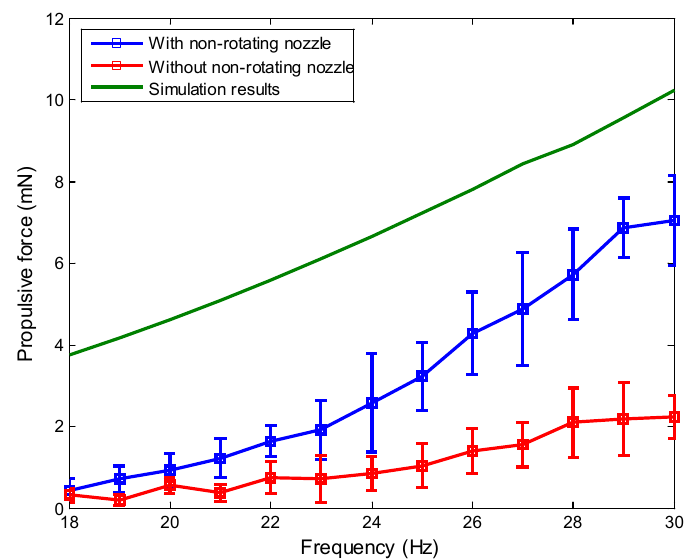
Figure 13. Measured results of the propulsive force.